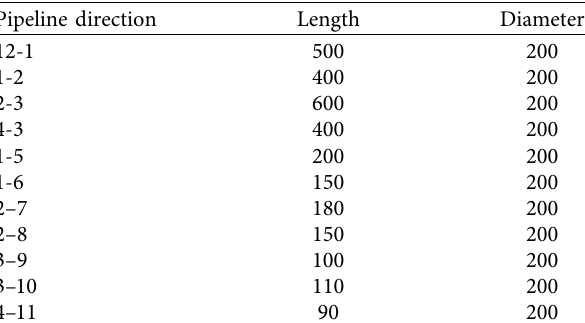
Table 9: Thermal pipe network parameters.